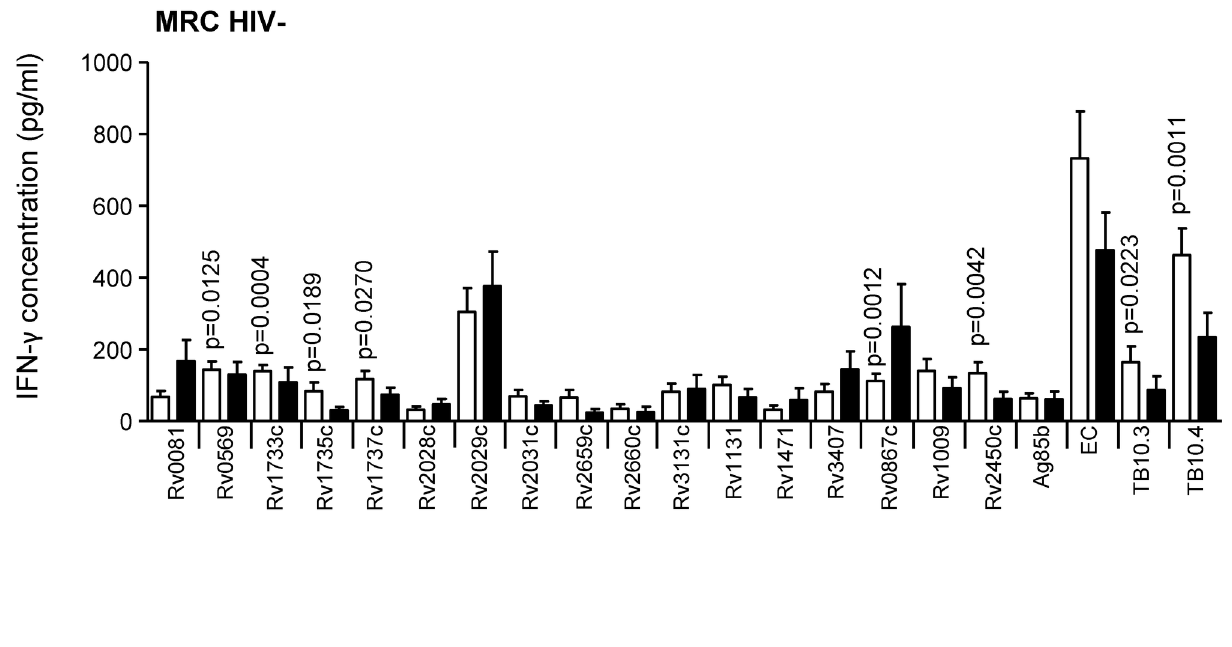
Figure 7. IFN-γ secretion in response to secreted, latent, and reactivation Mtb antigens in active TB and LTBI subjects, from The Gambia. IFN-γ ELISA was performed on supernatants collected after 7-day antigen stimulation of diluted blood from TB cases (black) and TST + (LTBI) controls (white) from MRC (The Gambia). Line indicates median, whiskers indicate 5–95% range and dots indicate outliers. Data were analysed by Mann-Whitney U-test for HIV – subjects. Significant differences are indicated.